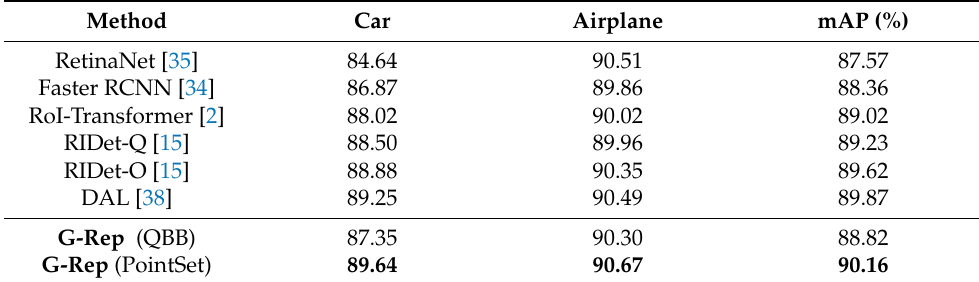
Table 9. Comparison of the AP with state-of-the-art methods on UCAS-AOD.